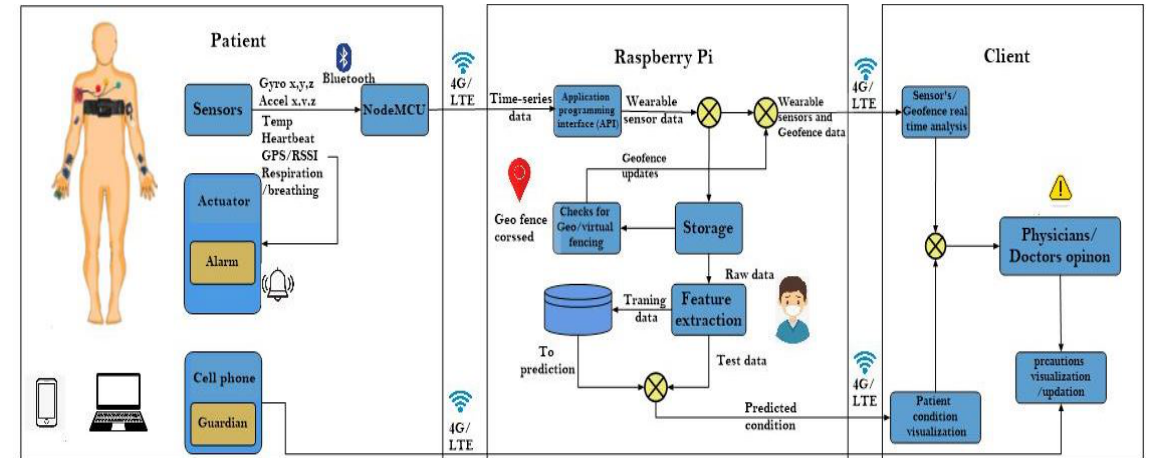
Figure 4. The proposed WIoT based framework for Geo-fencing and Remote Monitoring of COVID-19 susceptible and